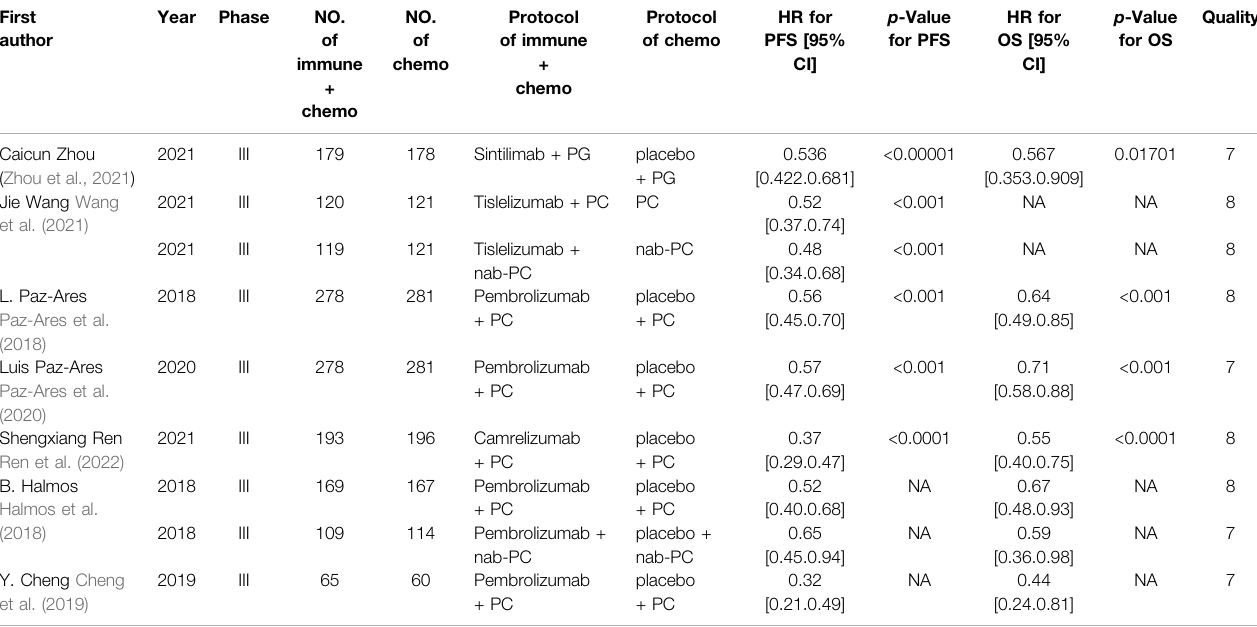
TABLE 1 | Basic characteristics of included studies.